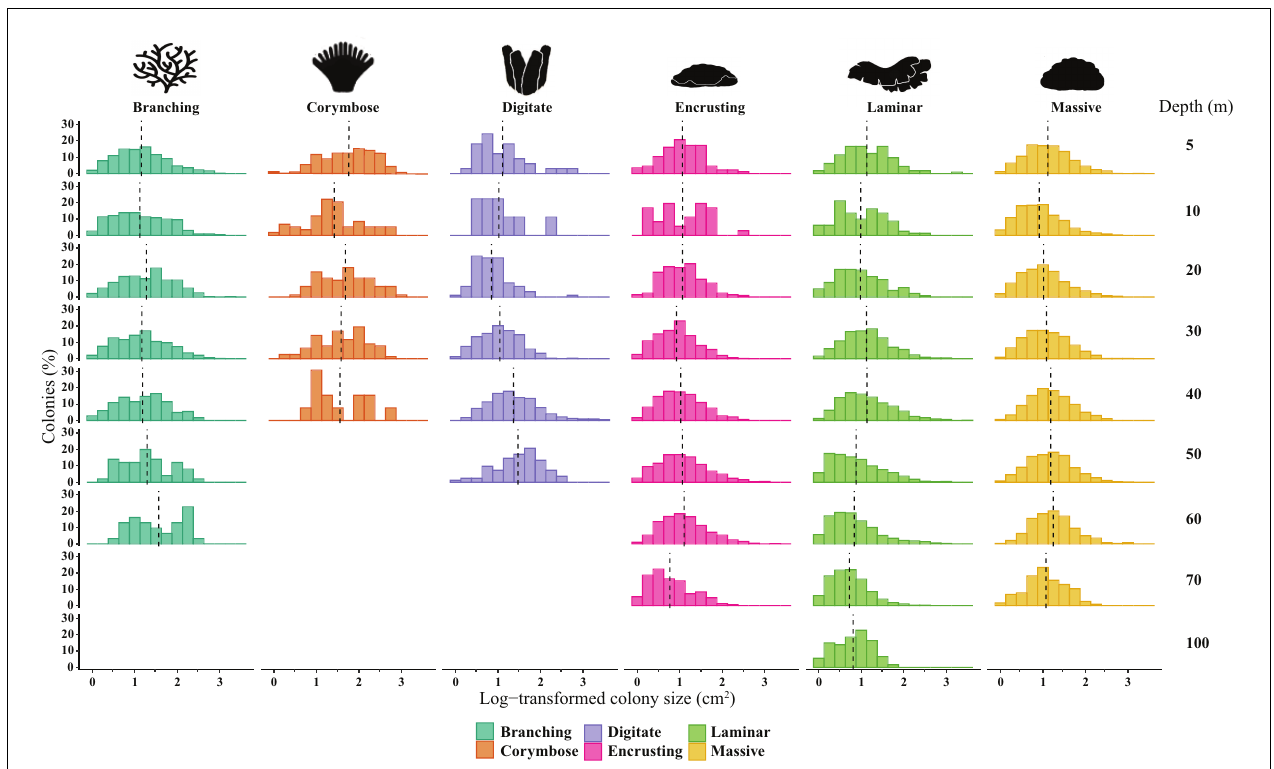
FIGURE 2 | Size-frequency distributions (SFDs) based on log-transformed size classes of six morphological categories: branching, corymbose, digitate, encrusting, laminar and massive across depths (5, 10, 20, 30, 40, 50, 60, 70, and 100 m; pooled among sites). Dashed black lines indicate mean log , and colors denote the different morphological